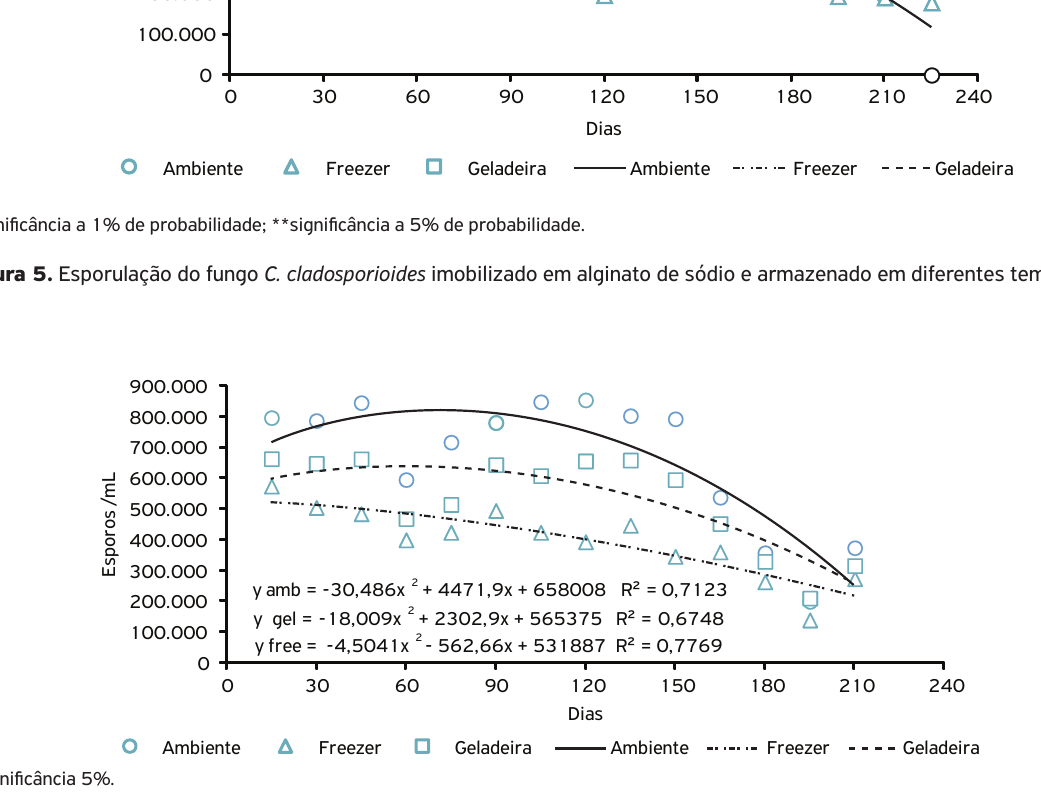
Figura 6. Esporulação de P. solitum imobilizado em alginato de sódio e armazenado sob diferentes